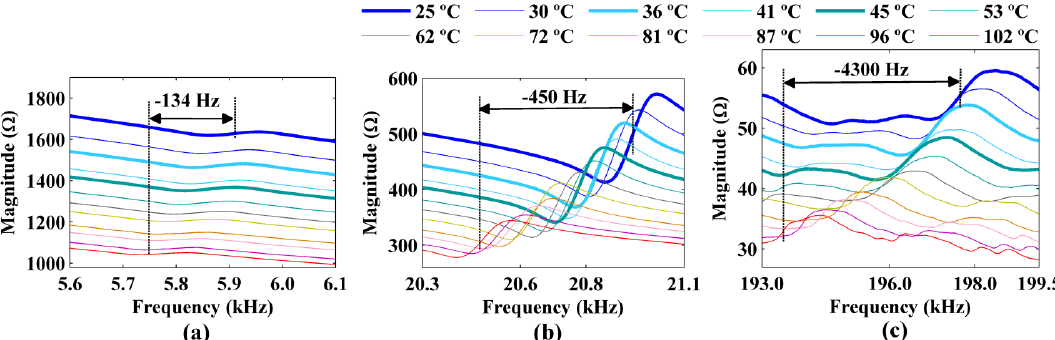
Figure 12. Frequency shifts of the magnitude of the impedance signatures for resonance peaks at ( a ) 5.91 kHz, ( b ) 20.95 kHz, and ( c ) 197.80 kHz considering the temperature at 25 °C as a reference.